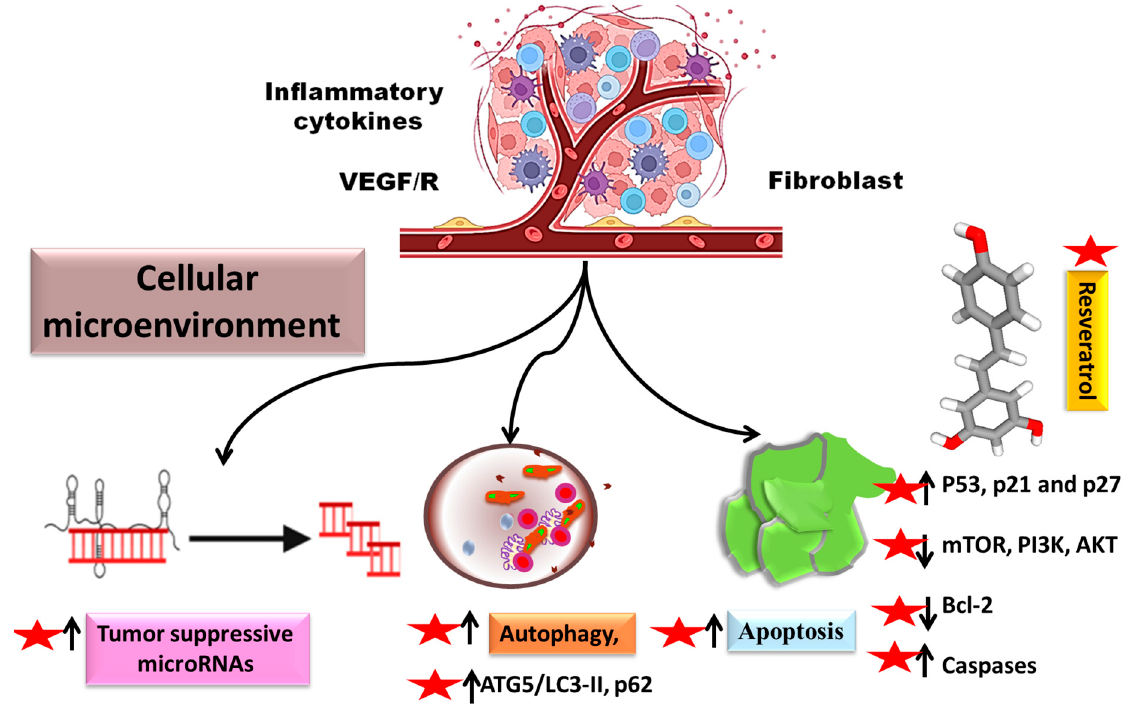
Figure 1. Mechanisms of action of resveratrol in the management of B-cell malignancies.